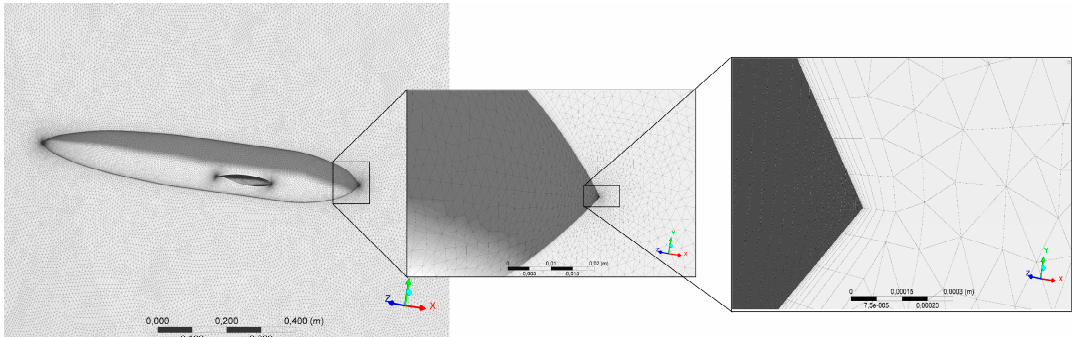
Figure 3. Fragments of the fluid domain unstructured mesh used for aerodynamic calculations with an inflated on the surface structured submesh allowing for a fine boundary layer resolution.